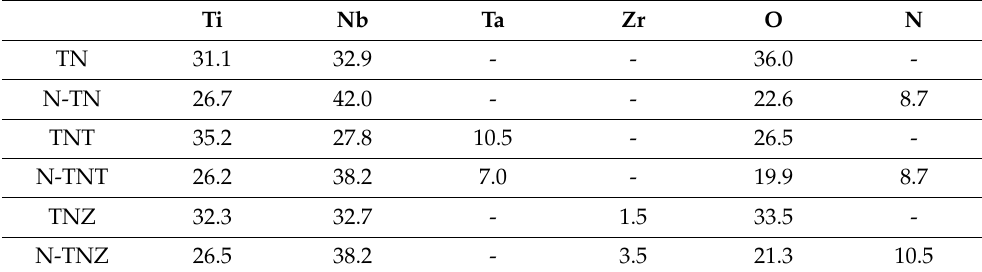
Table 1. Surface composition of native and modified titanium alloy, determined by XPS (weight